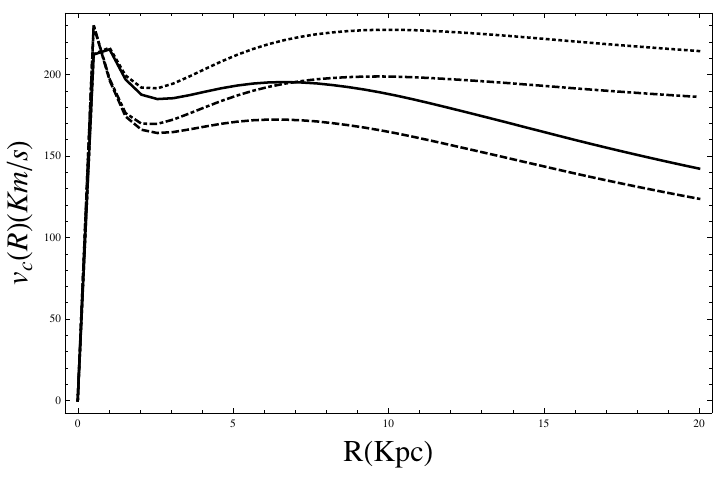
Figure 7. The global rotation curve in the framework of GR (dashed line), GR + DM (dashed and dotted line), FOG (solid line) and FOG + DM (dotted line). The values of “masses” are µ = 10 − 2 a − 1 and µ = 5 a − 1 . 1 2